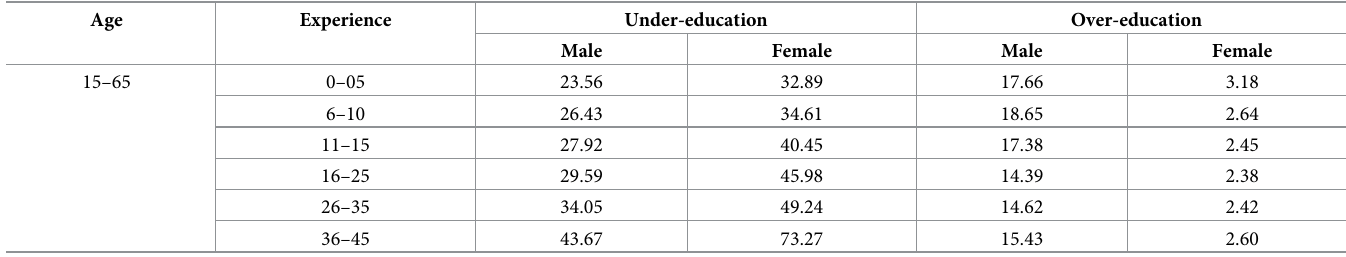
Table 3. Incidence of mismatch by experience.